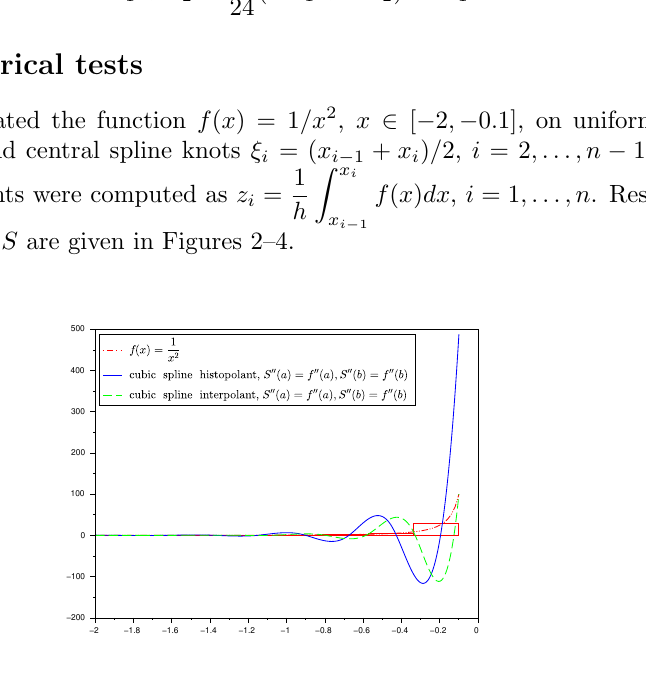
Figure 2. Cubic spline histopolant and interpolant for n =